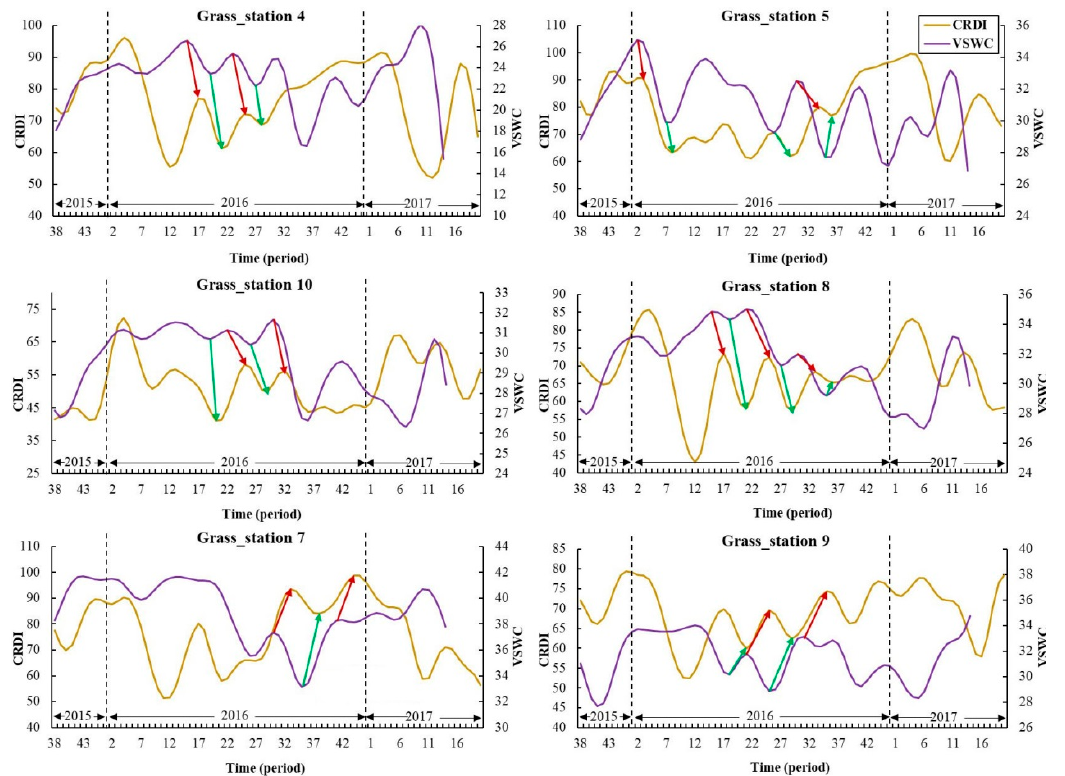
Figure 10. The indexes of CRDI and VSWC of grass in different geographical locations. The red arrow represents the lag of the peak, and the green arrow represents the lag of the valley. The dotted line represents the division of